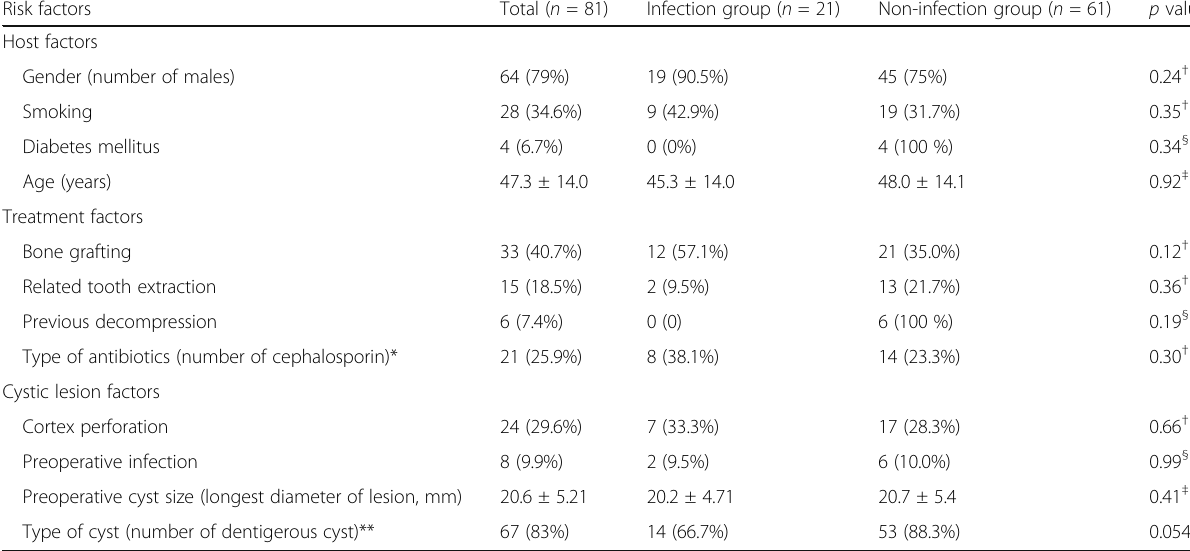
Table 1 Description of risk factors affecting infection after the surgery of cyst enucleation Risk